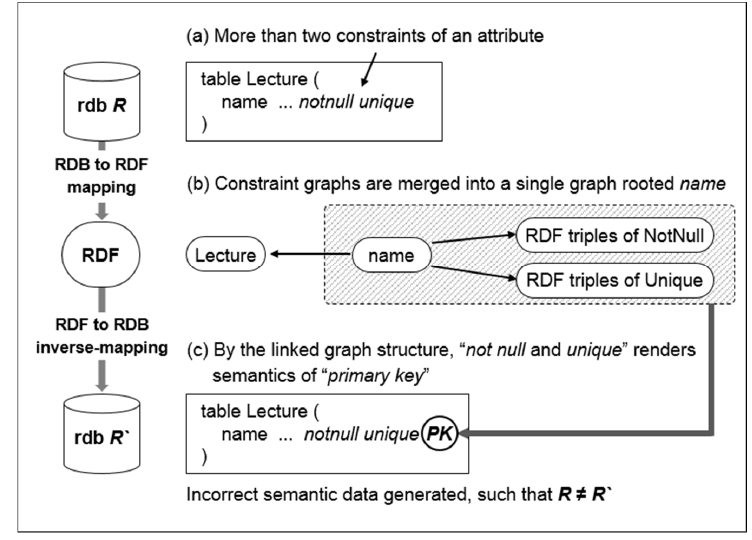
Figure 2. An example of problems encountered during a direct-mapping